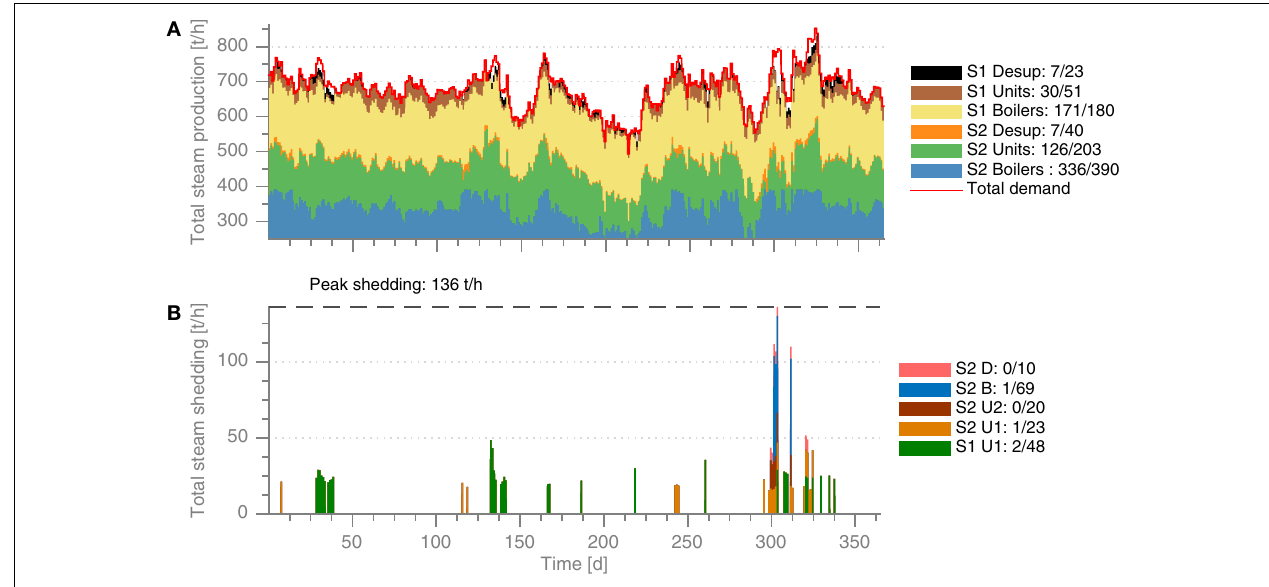
FIGURE 8 | Overall cluster distribution of steam (A) and load shedding due to undercapacity (B) .